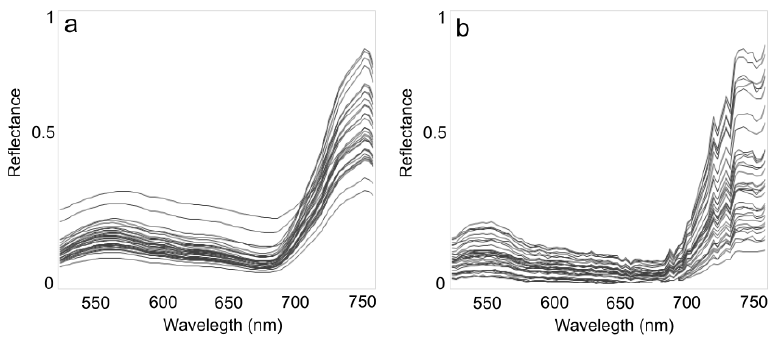
˝ ď φ ˝ ) from ( a ) UDC and ( b ) v ď 145